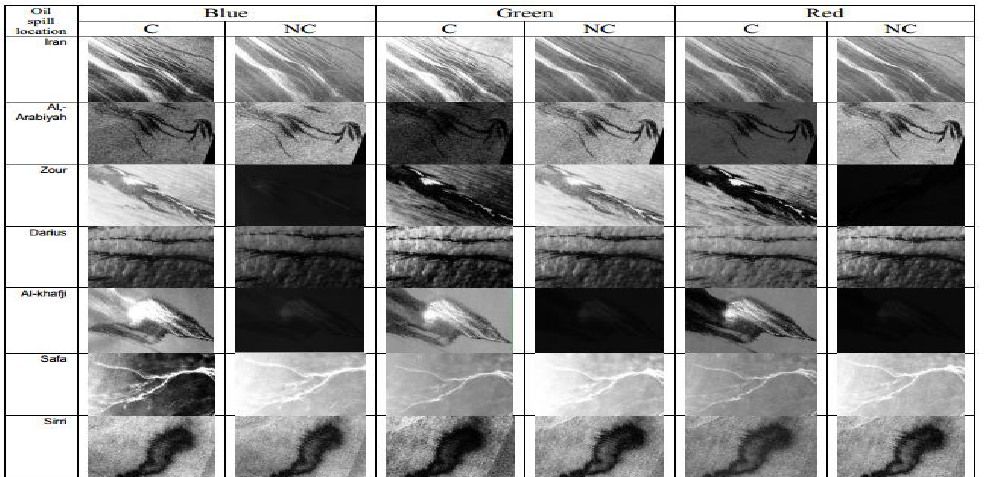
Figure 3. Output of calibrated (C) and non-calibrated (NC) spill Signatures in B, G, and R bands for selected zoomed inset of scene